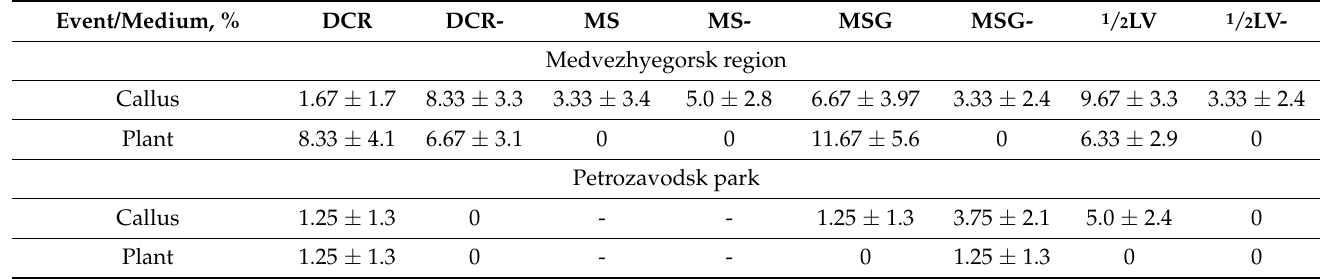
Table 3. Mean frequency of callus/plant formation from Pinus sylvestris mature seeds megagameto- phytes from different habitats on the nutrient media differed in composition and